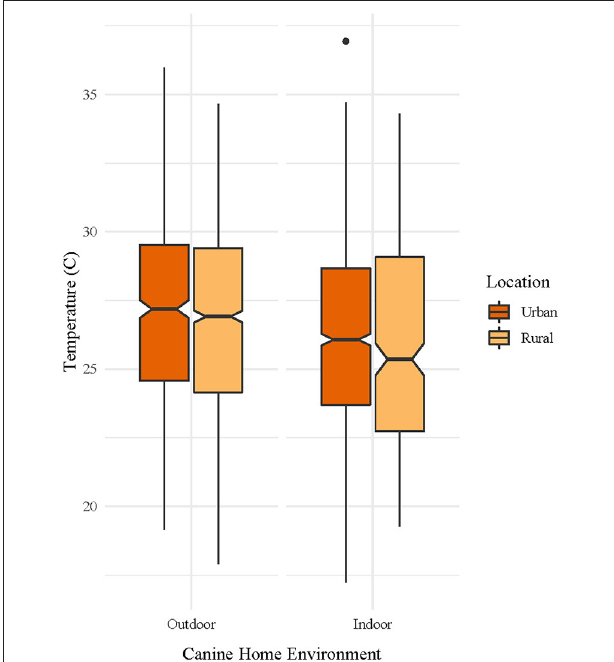
FIGURE 2 | Median and range of temperatures measured on canine pets, stratified by home environment (outdoor or indoor) and location (urban or rural). Canine pet and owner data were collected over a 6-day period for each dog, with staggered enrollment over a 10-day period in July 2017, using wearable iButton ® thermometers. Neighborhood ambient temperatures were captured using shielded iButton ® thermometers/hygrometers placed in neighborhoods and weather station data was downloaded from the National Weather Service weather station data